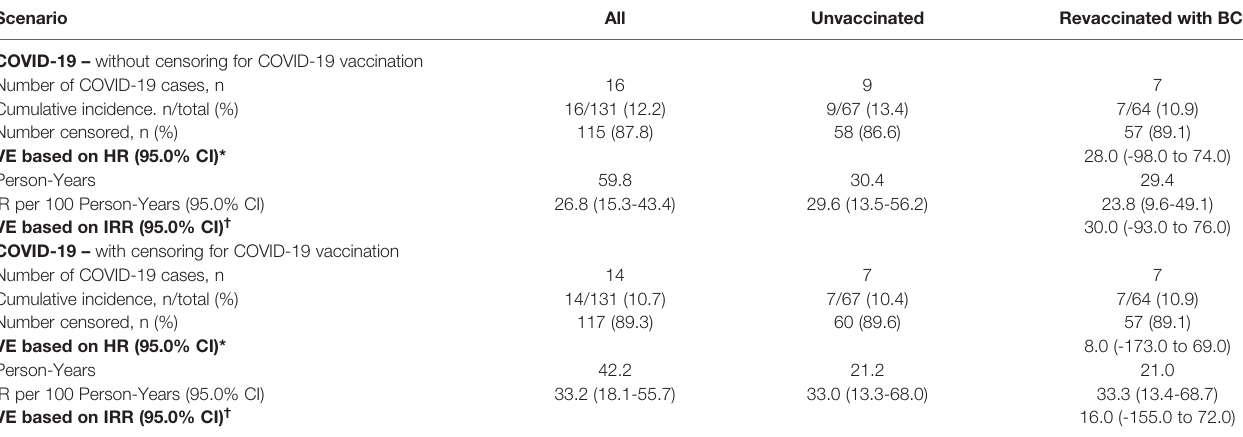
TABLE 4 | Vaccineef fi cacybasedonsymptomaticCOVID-19 infectioninbothscenarios:withoutcensoringforCOVID-19vaccinationandwithcensoringforCOVID-19vaccination.